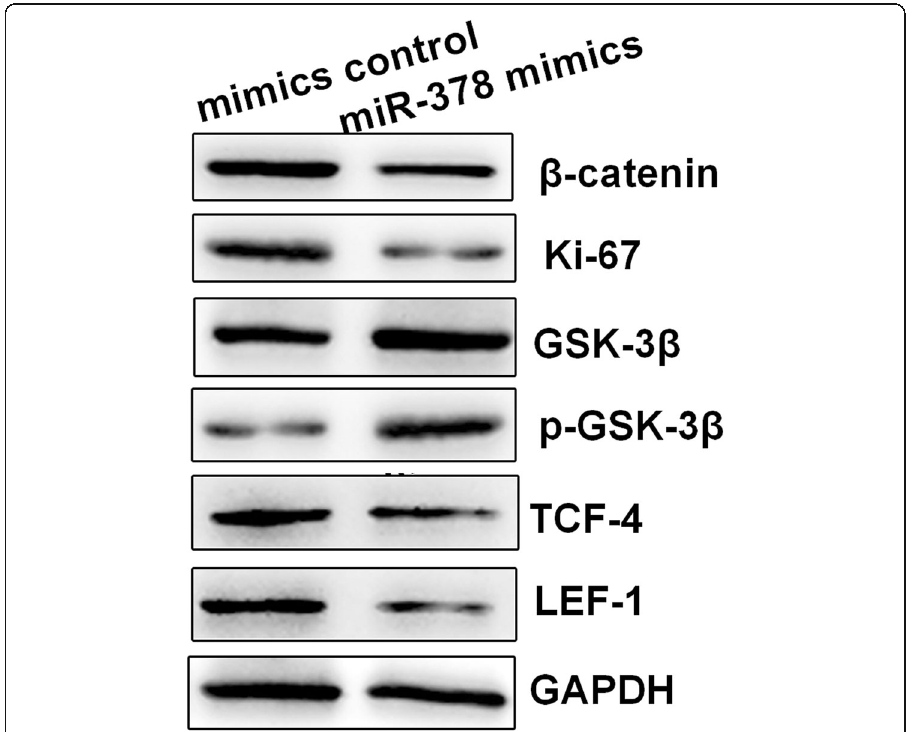
Fig. 6 The effect of miR-378 on the Wnt/ β -catenin pathway. Western blot was used to measure the levels of β - catenin, Ki-67, GSK-3 β , p-GSK-3 β , and the transcription factors TCF-4 and LEF-1 when miR-378 was